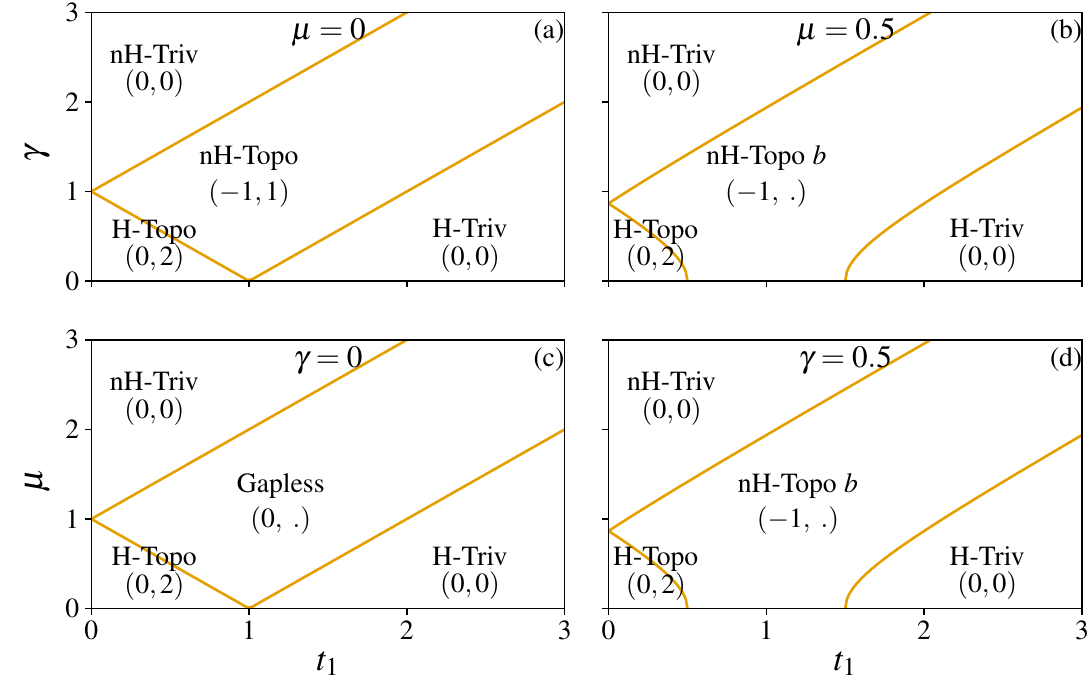
Figure 2: Phase diagram of the extended non-Hermitian SSH model as a function of t and γ for (a) µ = 0, (b) µ = 0.5, and as a function of t 1